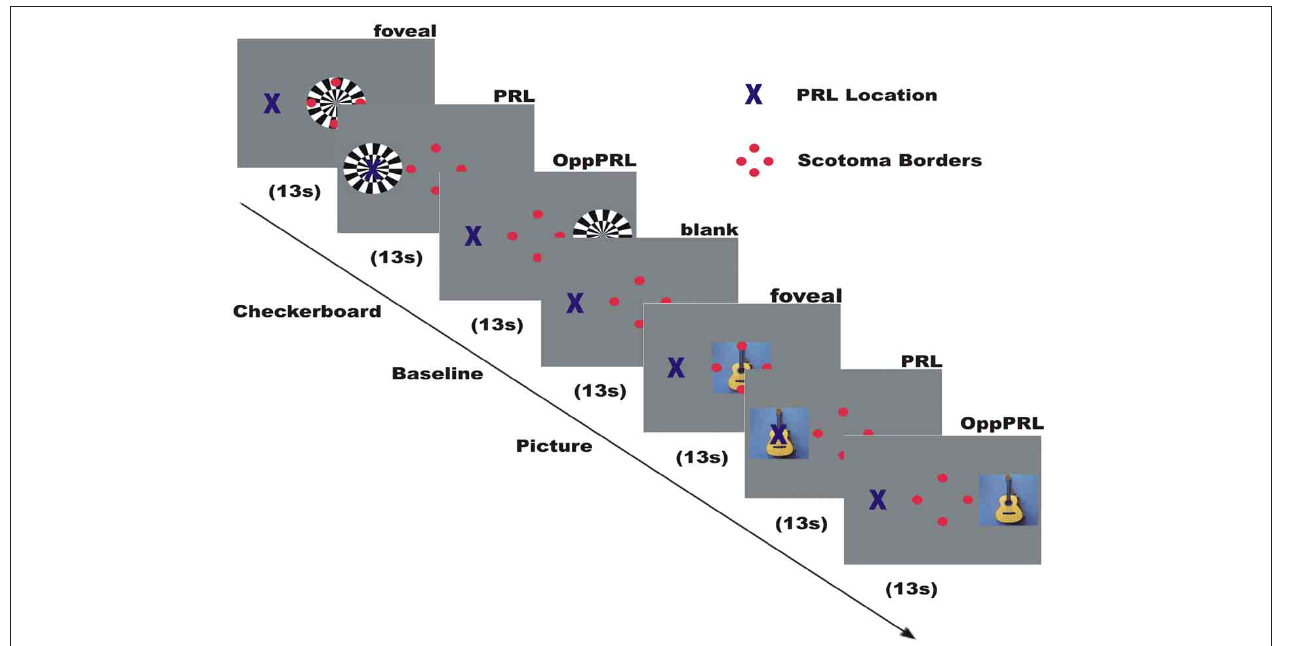
FIGURE 2 | Illustration of the time course of a typical run in an fMRI session. Direct stimulation was conducted in the fovea, the PRL, and the opposite PRL either with checkerboard or images of everyday